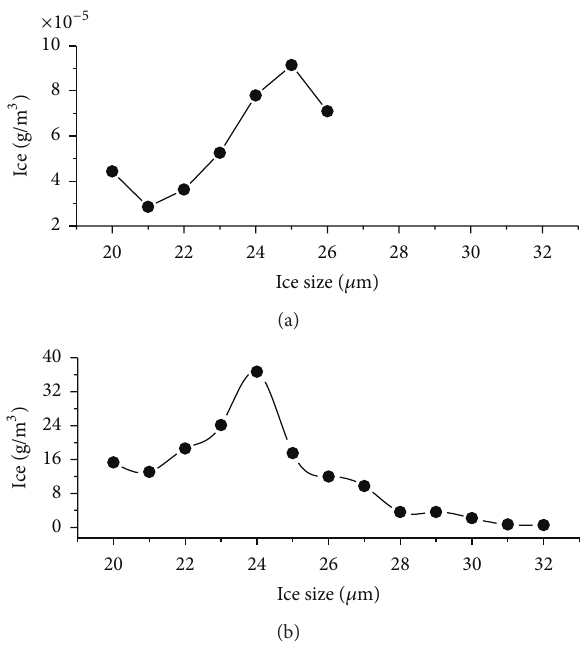
Figure 4: Relation between mean cloud ice size and cloud ice concentration averaged during 2000–2011 period at 12km altitude (a) over the continental region L1 and (b) oceanic region